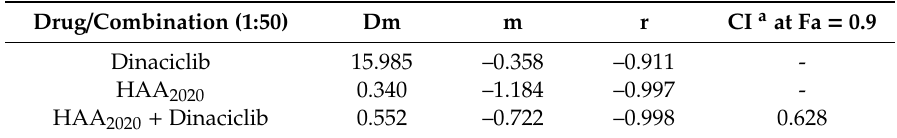
Table 3. The combination index parameters of HAA 2020 , dinaciclib and their combination. Drug / Combination